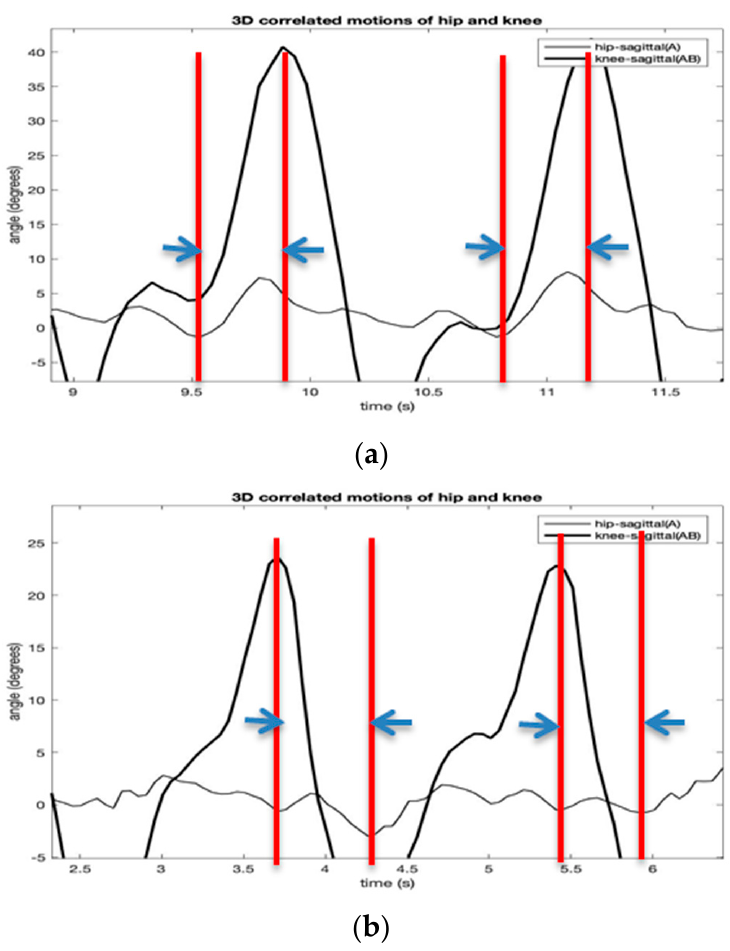
Figure 6. The normalized gait phase diagrams of the hip and knee joint angles of Figure 5 with normal ( a ) and simulated hemiplegic walking ( b ) (hip-sagittal vs. knee-sagittal).